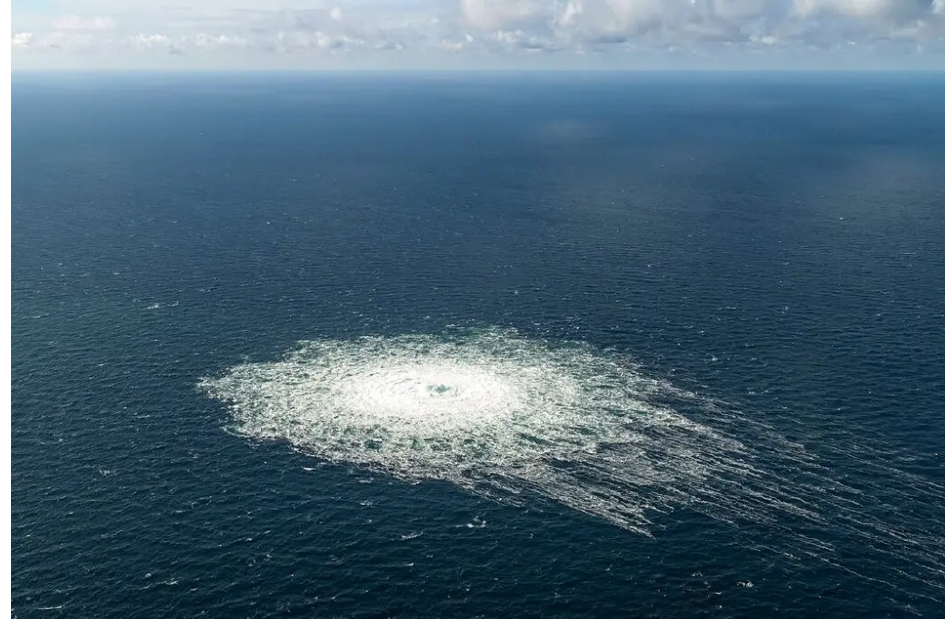
Figure 4. The Danish military showing gas welling up off the coast of Bornholm island. Source: Armed Forces of Denmark, via Associated Press and [59,60].